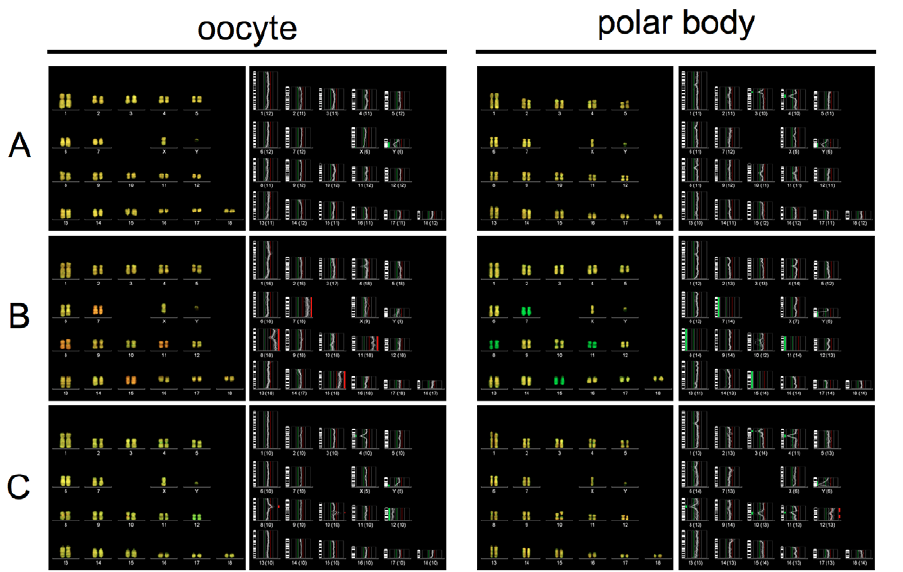
Figure 1. Detection of chromosome segregation errors by comparative genomic hybridization (CGH). Panel A: CGH analysis of euploid oocyte (left panel) and the corresponding polar body (right panel). Panel B: CGH analysis of oocyte (left panel) and the corresponding polar body (right panel) with non-disjunction of chromosomes 7, 8, 11 and 15. Panel C: CGH analysis of oocyte (left panel) and the corresponding polar body (right panel) with premature segregation of sister chromatids of chromosome 12.